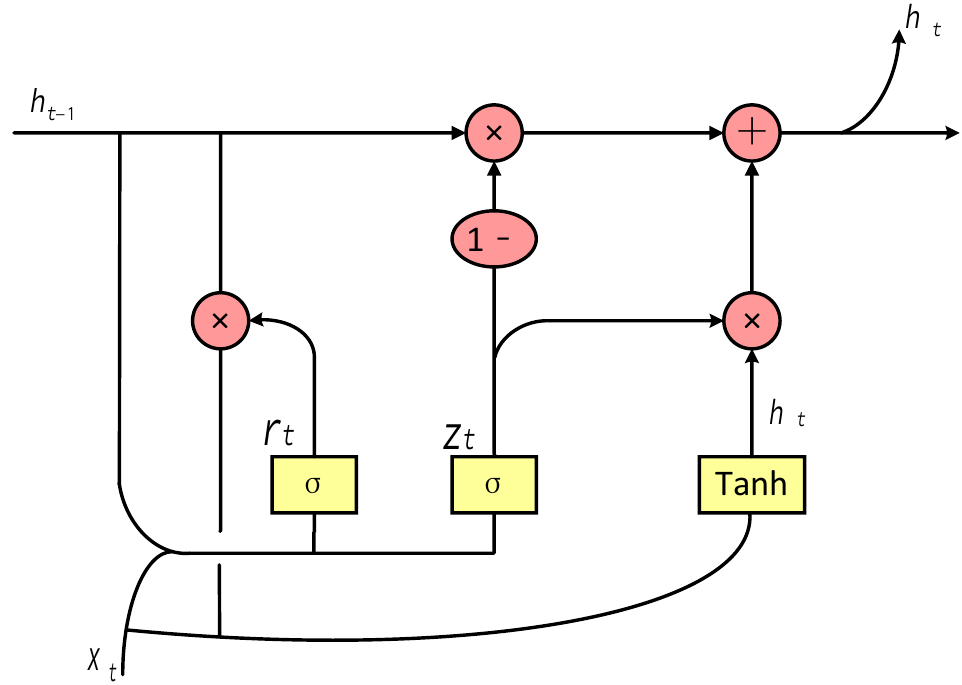
Figure 7. GRU structure diagram.